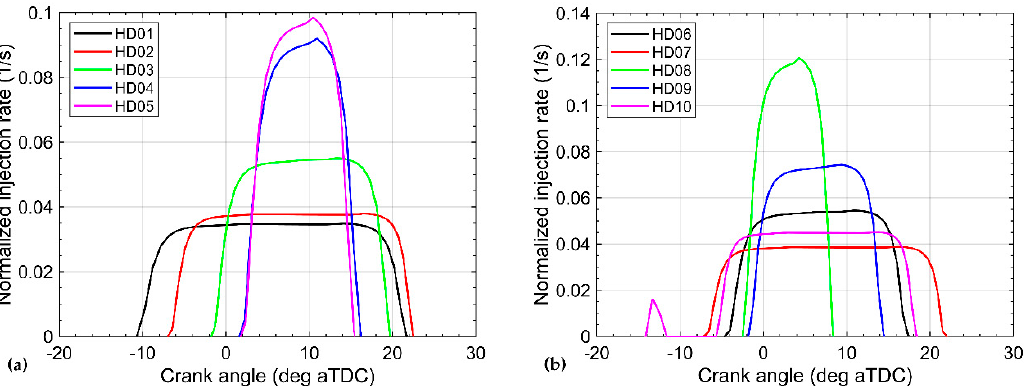
Figure 6. Fuel injection rates as a function of crank angle degree (assuming 0 as firing TDC) for operating conditions ( a ) from 1–5 and ( b ) 6–10, as listed in Table 2.